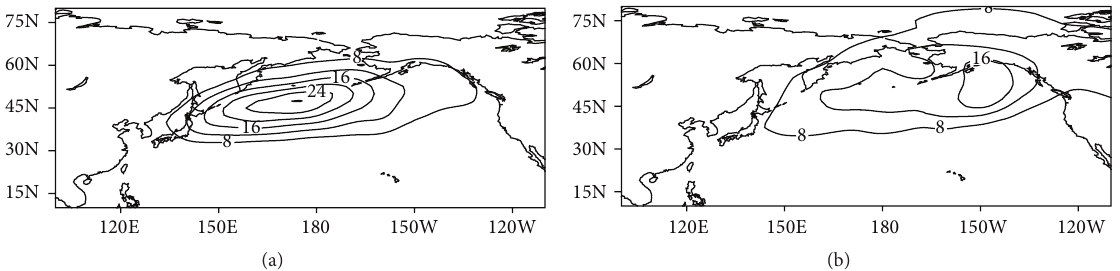
Figure 8: The WSE related storm track (a) and the ESE related storm track (b), which are obtained based on the monthly index of PCw and PCe (unit: dagpm 2 ).